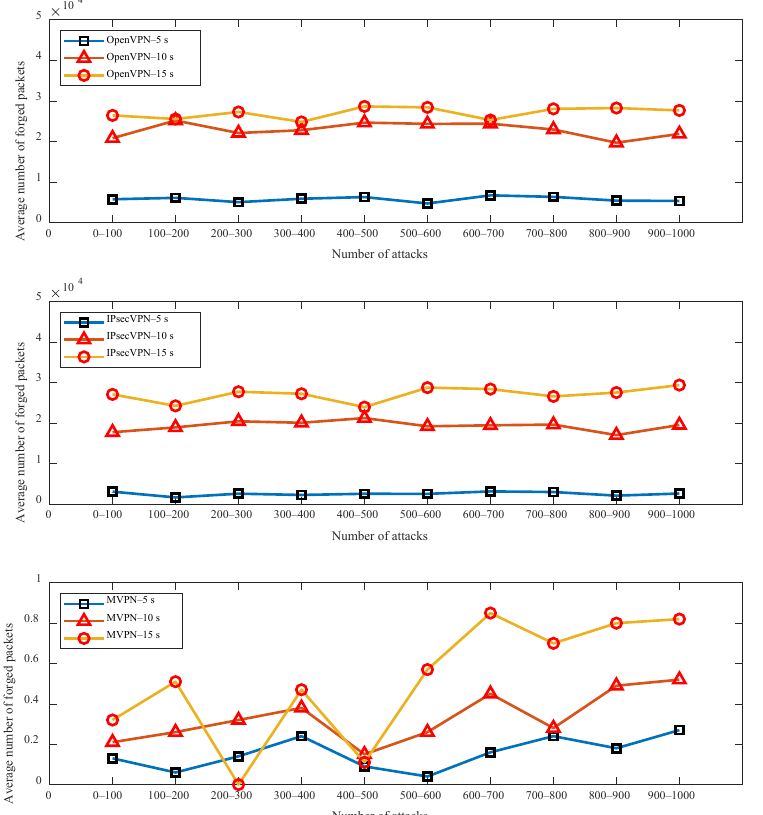
Figure 11. The number of forged packets received by the client at different timeout times. Experimental data show that the average number of forged packets received by the OpenVPN client and IPsec VPN client per attack, respectively, was 27,029 and 27,049 when the timeout duration was 15 s. However, the MVPN client received only 0.515 on average. The MVPN reduced the number of forged packets passing through the tunnel to less than one in each attack. This is why MVPN could reduce the attack success rate to zero under the same experimental conditions. 6.4. Performance Testing (Experiment IV) Performance testing was conducted to evaluate the performance of the system in the real network environment. In this paper, the experimental environment was set up as shown in Figure 12. The experimental environment included seven physical hosts and servers, four switches, and a router. The VPN proxy consisted of a Centos 7 system server and a heterogeneous board. The heterogeneous board integrated multiple houseware ar- chitectures (X86 and arm) and installed different operating systems (ubuntu 18.04 and centos 7). The two clients were composed of Ubuntu 18.04 and Win7.